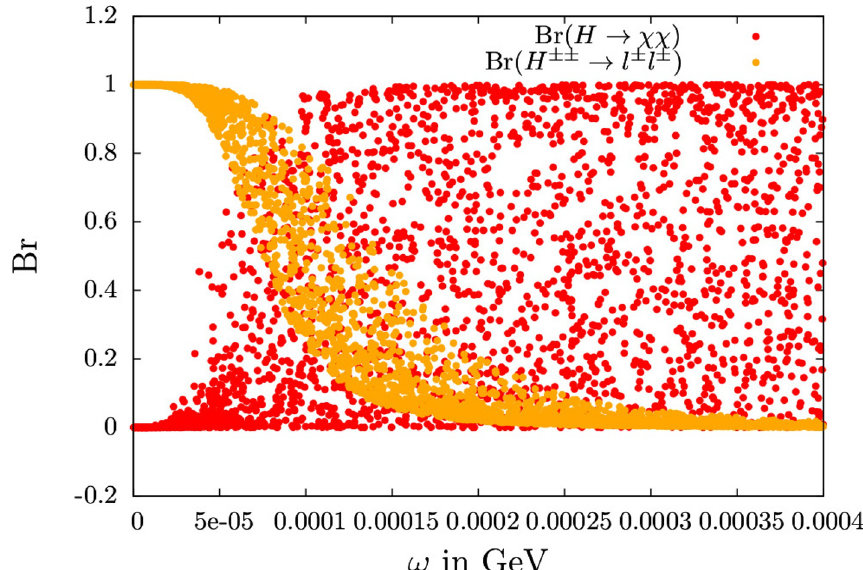
Figure 5 . Distribution of various branching ratios as a function of ! .